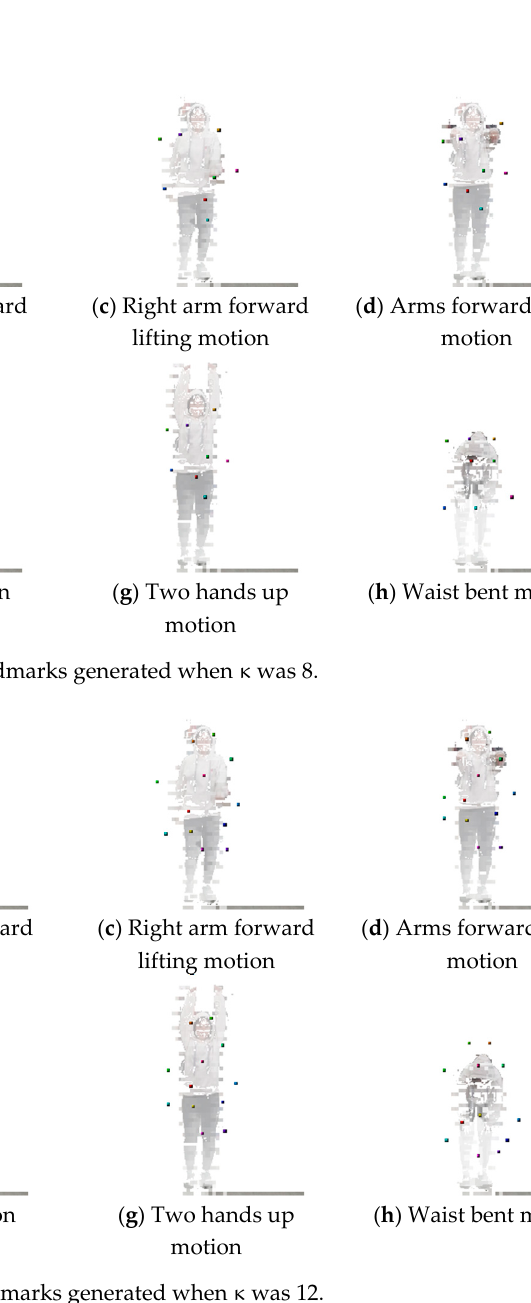
Figure A2. 3D landmarks generated when κ was 12.